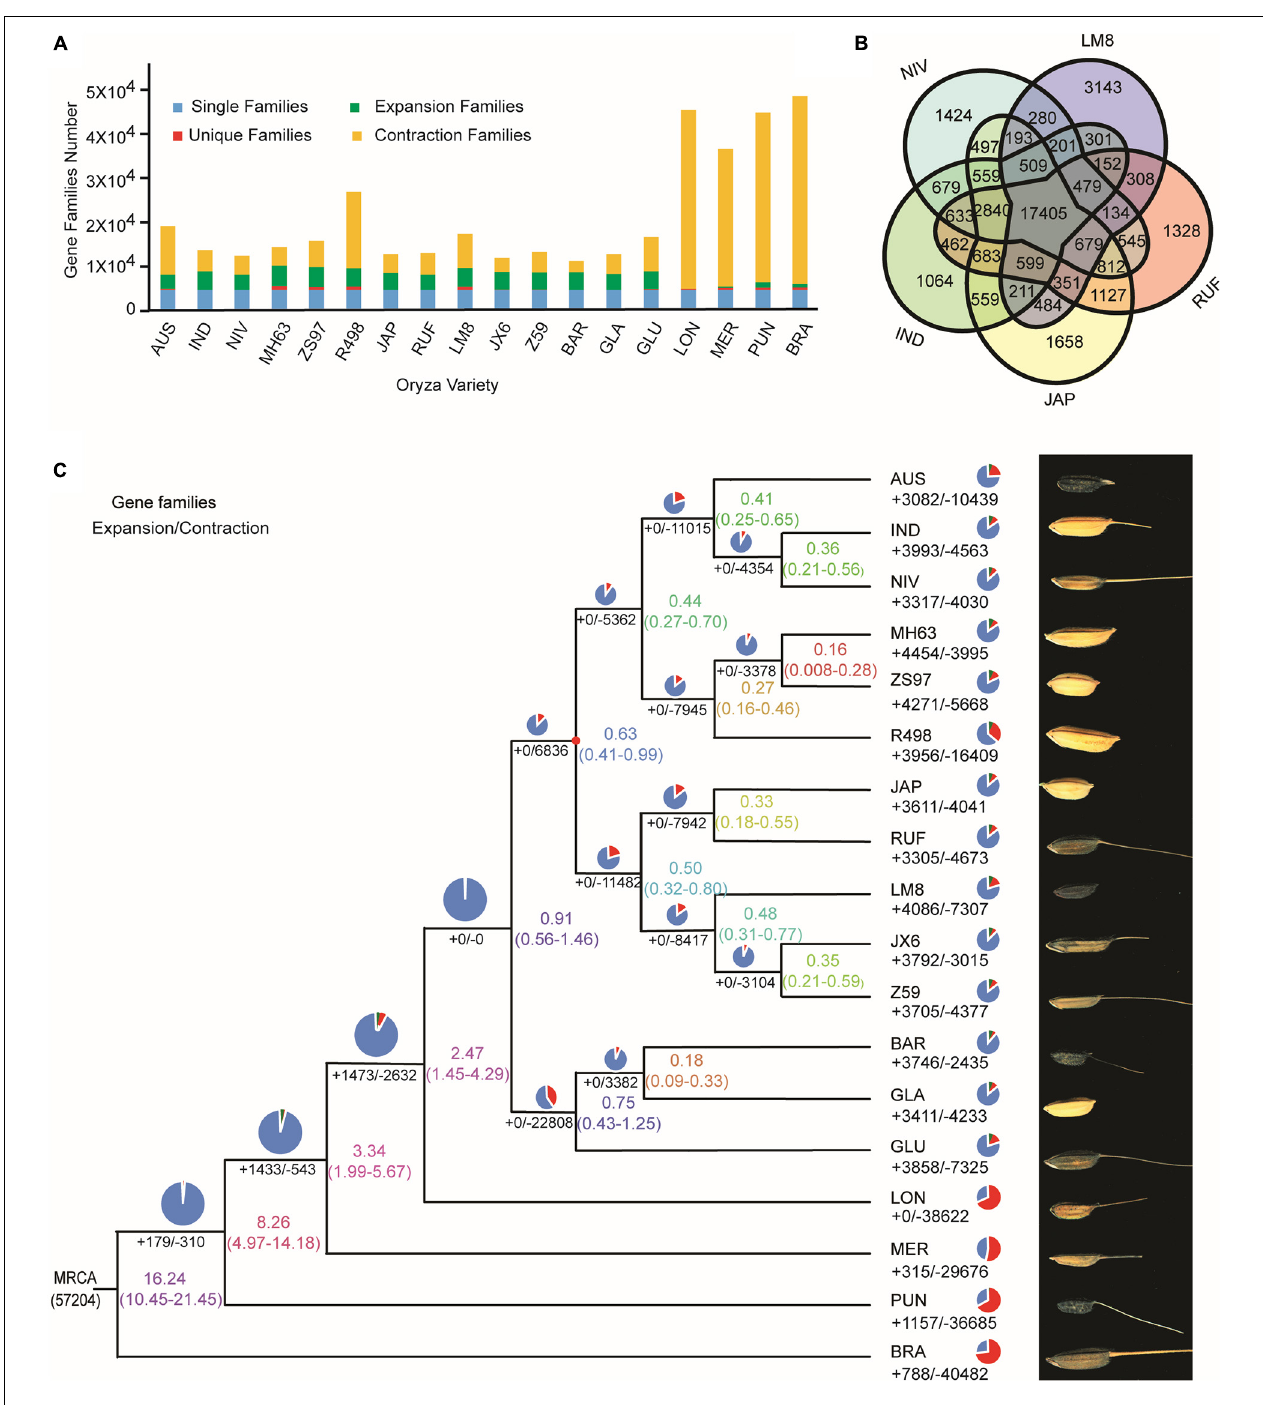
FIGURE 5 | Comparative genomics analyses of LM8 with other Oryza genomes. (A) Statistics of gene families in 18 Oryza genomes. (B) Core and dispensable genes from five reference genomes. The numbers in the species section and overlapping section indicate the numbers of specific and shared gene families, respectively. IND, O. sativa ssp. indica . JAP, O. sativa ssp. japonica . RUF, O. rufipogon . NIV, O. nivara . and LM8, O. sativa f. spontanea . (C) Phylogenetic relationships and grain phenotypes of LM8 and other Oryza genomes. Pie charts represent total gene families, consisting of contracted gene families (red), expanded gene families (green), and unchanged gene families (blue). The numbers of genes in expanded (+) and contracted (–) gene families in each rice variety are shown with the rice variety name farthest to the right. The lineage divergence times are indicated on the nodes and nodes marked in red are known fossil time points. O. brachyantha was used as the outgroup. MRCA, most recent common ancestor. AUS, O. aus . IND, O. sativa ssp. indica . JAP, O. sativa ssp. japonica . GLA, O. glaberrima . BAR, O. barthii . GLU, O. glumaepatula . MER, O. meridionalis . RUF, O. rufipogon . NIV, O. nivara . LON, O. longistaminata . PUN, O. punctata . BRA, O. brachyantha . JX-6, O. rufipogon var. JX-6. Z59, O. rufipogon var. Z59. MH63, O. sativa ssp. indica var. Minghui63. ZS97, O. sativa ssp. indica var. Zhenshan97. R498, O. sativa ssp. indica var. Shuihui498. and LM8, O. sativa f. spontanea .